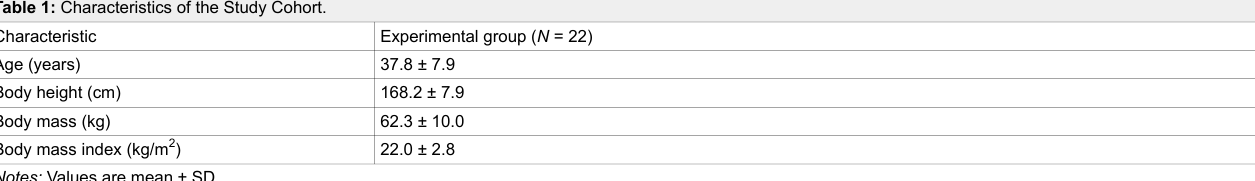
Table 1: Characteristics of the Study